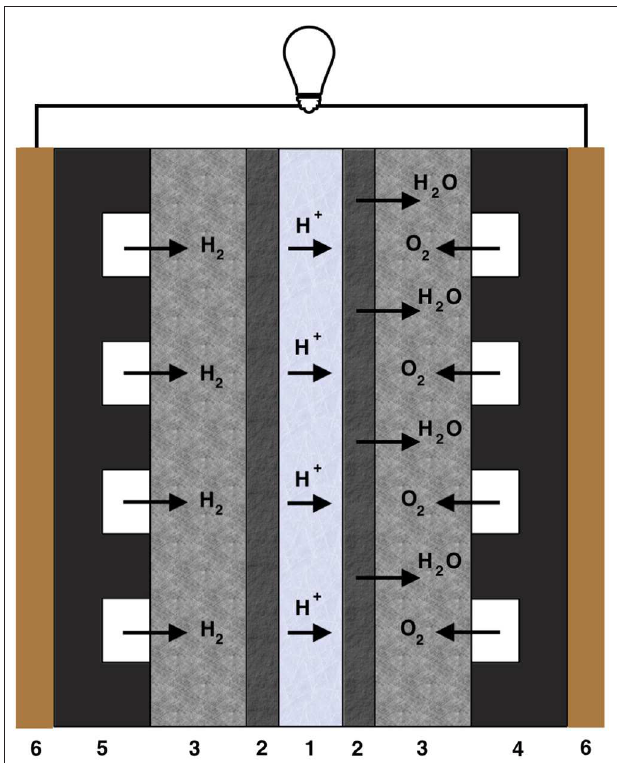
FIGURE 1 | Schematic picture of the PEMFC. The layer thickness is given in parenthesis. For abbreviations, see text. 1—PEM ( ∼ 50–150 µ m), 2—CL (